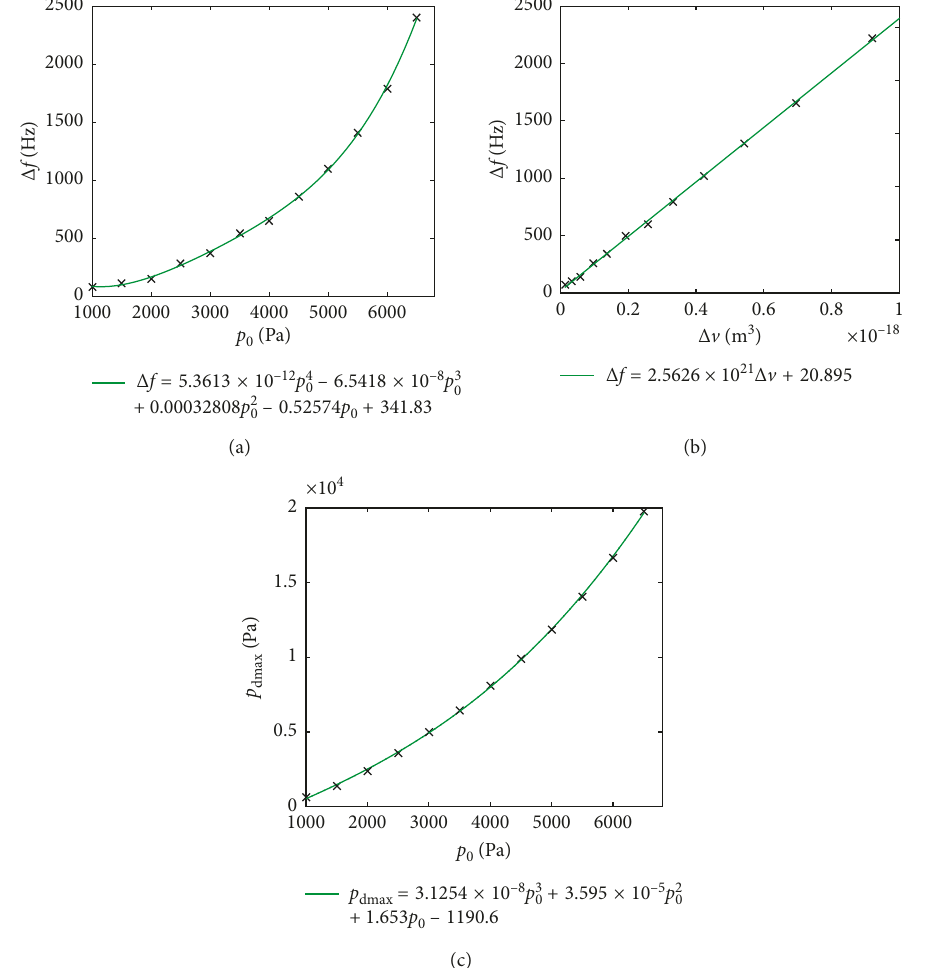
Figure 2: Fitting curves in Case 1 of frequency shift Δ f vs. pressure amplitude at the source p volume increase Δ v (b) and maximal value of difference-frequency pressure amplitude p amplitude at the source p